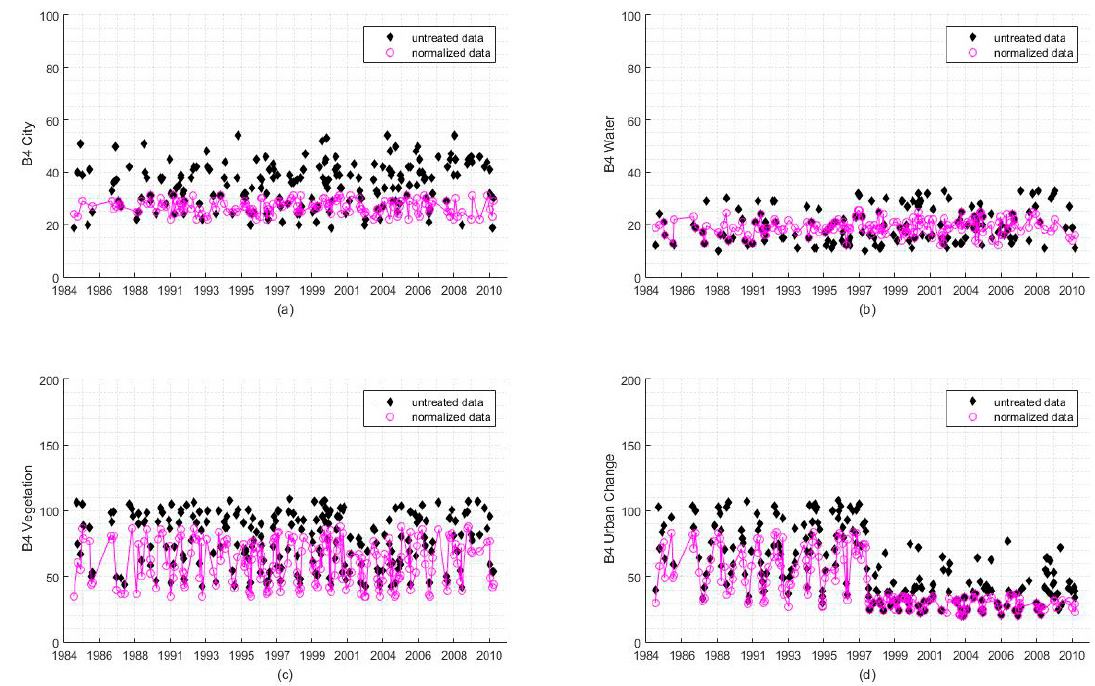
Figure 8. Comparison of the gray-scale values before and after radiometric normalization in long time-series sequences. Panels ( a – c ) present the comparison for three different land cover types: city, water body, and vegetation. The land cover did not change during the time period of observation. Panel ( d ) indicates radiometric normalization results for an area with changes in land surface. The pixel before 1997 corresponds to vegetation, whereas the pixel has changed to urban buildings after 1997.